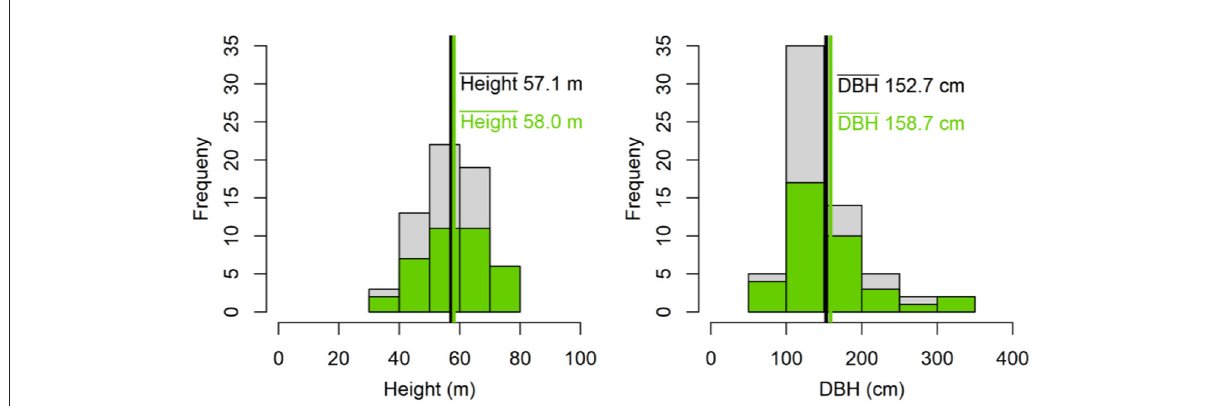
FIGURE10 Histogram and mean values of tree height and DBH of all RS trees ( n = 66) that have been identified using remote sensing and validated by field measurements. Green color shows histogram of trees within proximity (3km buffer) of the 10 sites ( n = 37).